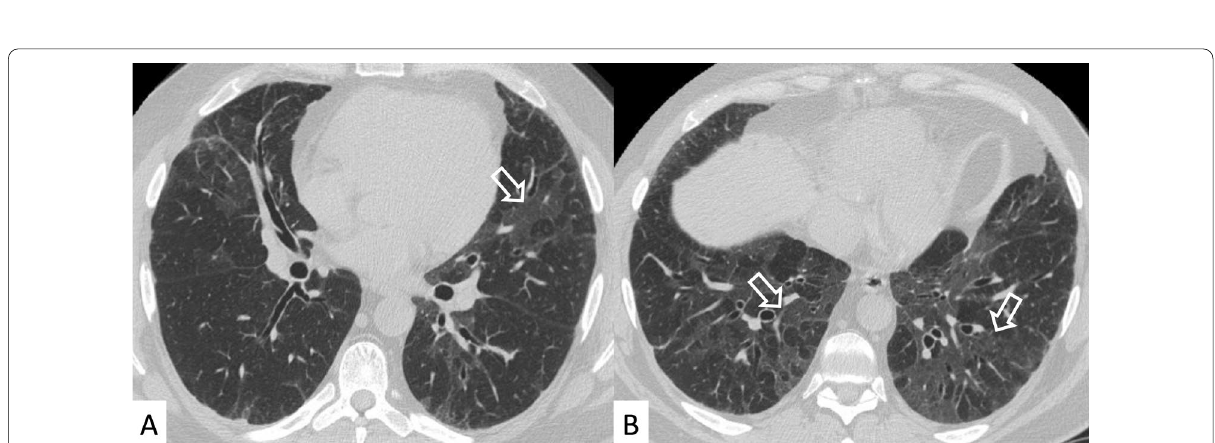
Fig. 3 Axial HRCT images of an NSIP pattern in a patient with rheumatoid arthritis. A , B Ground-glass opacities (empty white arrows) can be appreciated through the pulmonary parenchyma. The heterogeneous distribution of ground glass regions reflects areas of inflammation— alternated to normal lung